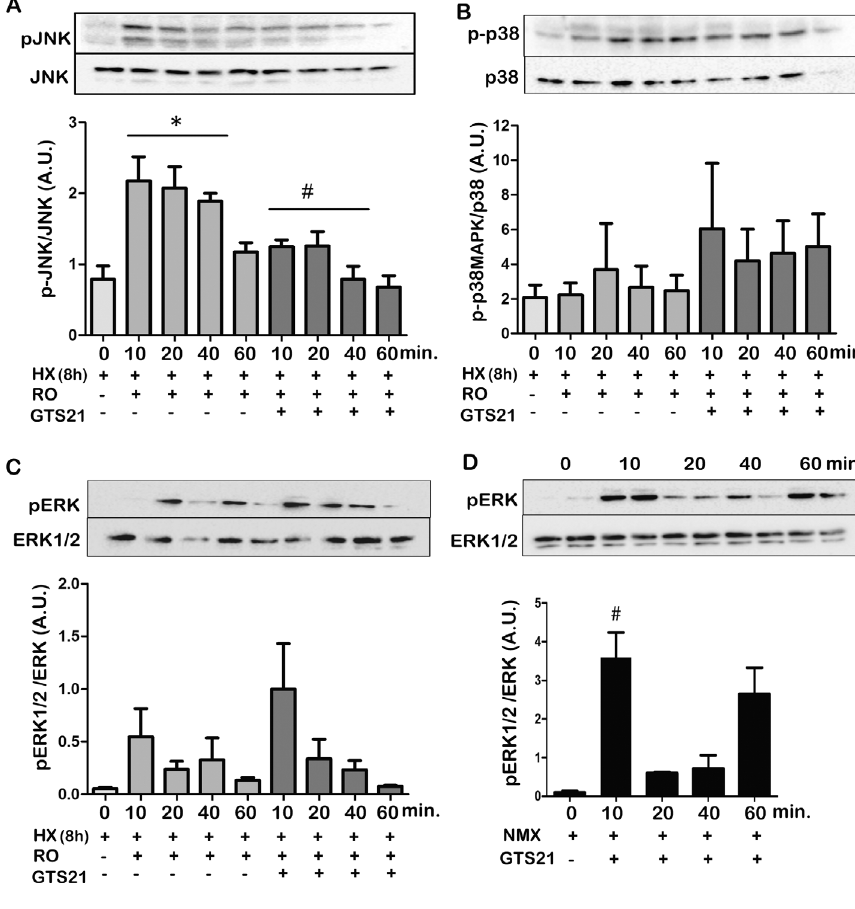
Figure 6. α 7nAChR-activated intracellular signaling pathways in cultured cardiomyocytes. NRVM cultures exposed to 8-h hypoxia (HX) followed by reoxygenation (RO) with or without GTS21 (10 -9 M) treatment; n = 4/time point; Western blots show total and phos- phorylated protein kinases. Bar graphs show the quantitation of immunoreactive bands (AU, arbitrary units). (A) ANOVA was used to determine statistical significance among p-JNK/JNK values at 10, 20, 40 min. RO versus HX at 0 min. * p < 0.01; two-tailed Student t test was used to determine statistical significance between untreated and GTS-treated cells at the same time point # p < 0.05 at 10, 20, 40 min. RO + GTS versus RO at 10, 20, 40 min, respectively. (B) p-p38MAPK to total p38MAPK and (C) pERK1/2 to total Erk1/2. (D) NRVMs under normoxic (NMX) conditions treated with GTS21 showing pERK1/2 /ERK ratios; # p < 0.05 versus (-)GTS at 0